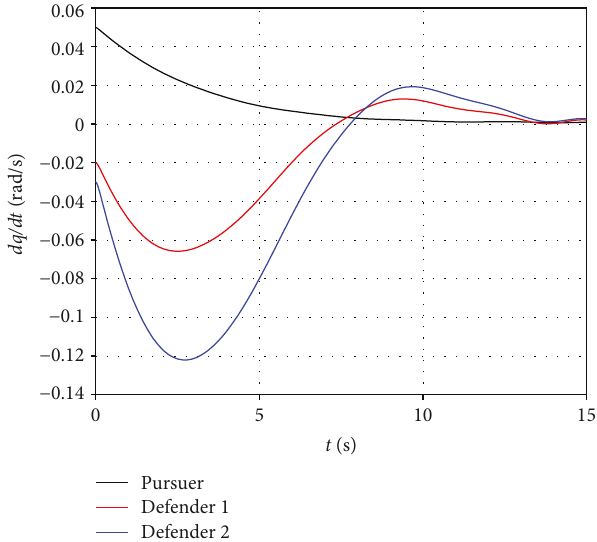
Figure 9: Four aircraft fl ight trajectories (one-side intercept with cooperation of Evader).